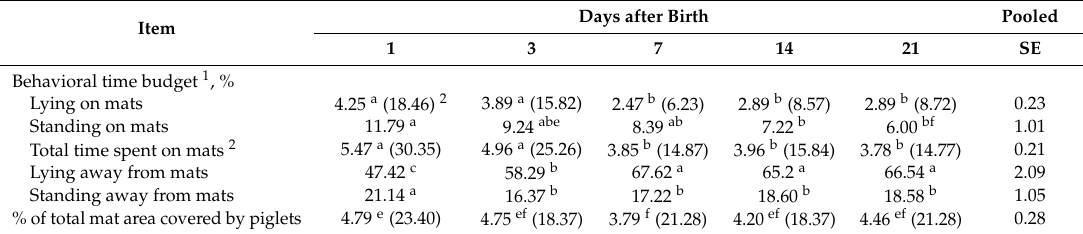
Table 6. Selected time budget for postures at di ff erent days of age (Trial 3). Days after Birth Pooled Item 1 3 SE Behavioral time budget 1 , % Lying on